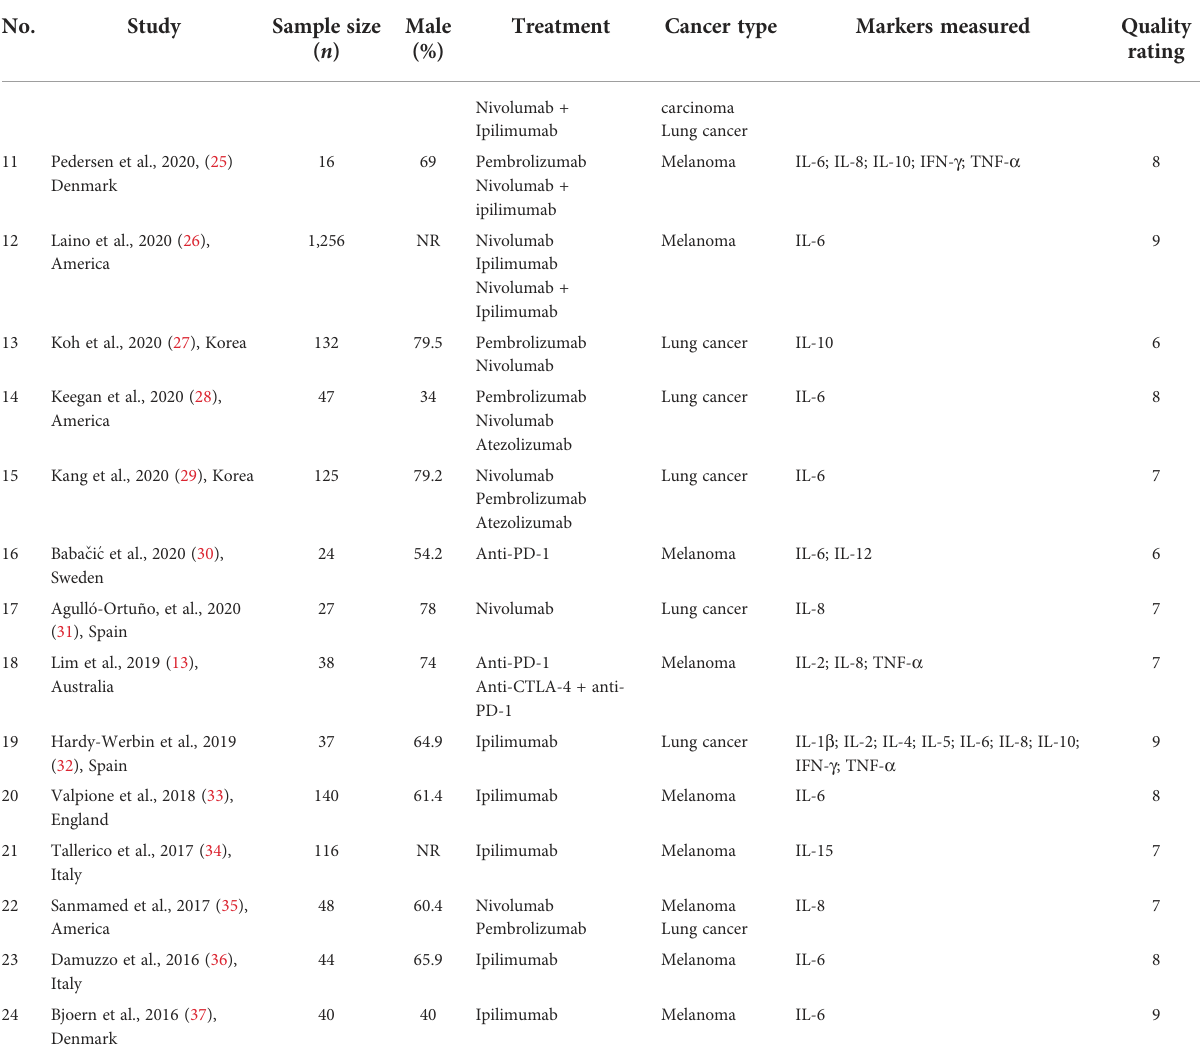
detection method were associated with higher heterogeneity compared with other regions (e.g., America or China), other cancer types (e.g., lung cancer or prostate cancer), other treatment methods (e.g., nivolumab or pembrolizumab), other sample types (serum or plasma), other detection methods (e.g., ELISA or Luminex), and baseline sample type (Table 3). Meta- regression analysis did not show any statistically signi fi cant covariates that could explain the heterogeneity (Supplementary asymmetry and the p -value of Egger ’ s test was less than 0.05 publication